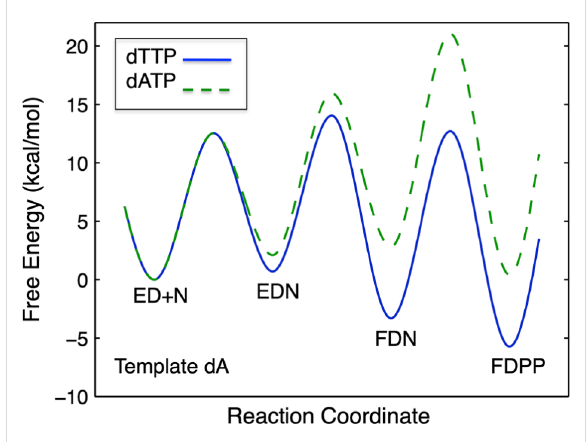
Figure 7: Free energy profile for DNA polymerization. Free energy profiles for a correct base pair (solid blue line) and a mismatch (dashed green line) were computed from data presented in